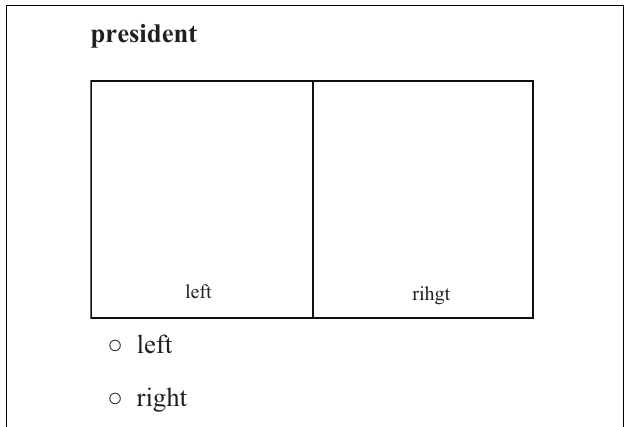
FIGURE 1 | Spatial placement task (the upper and lower space positions of the two options were random).